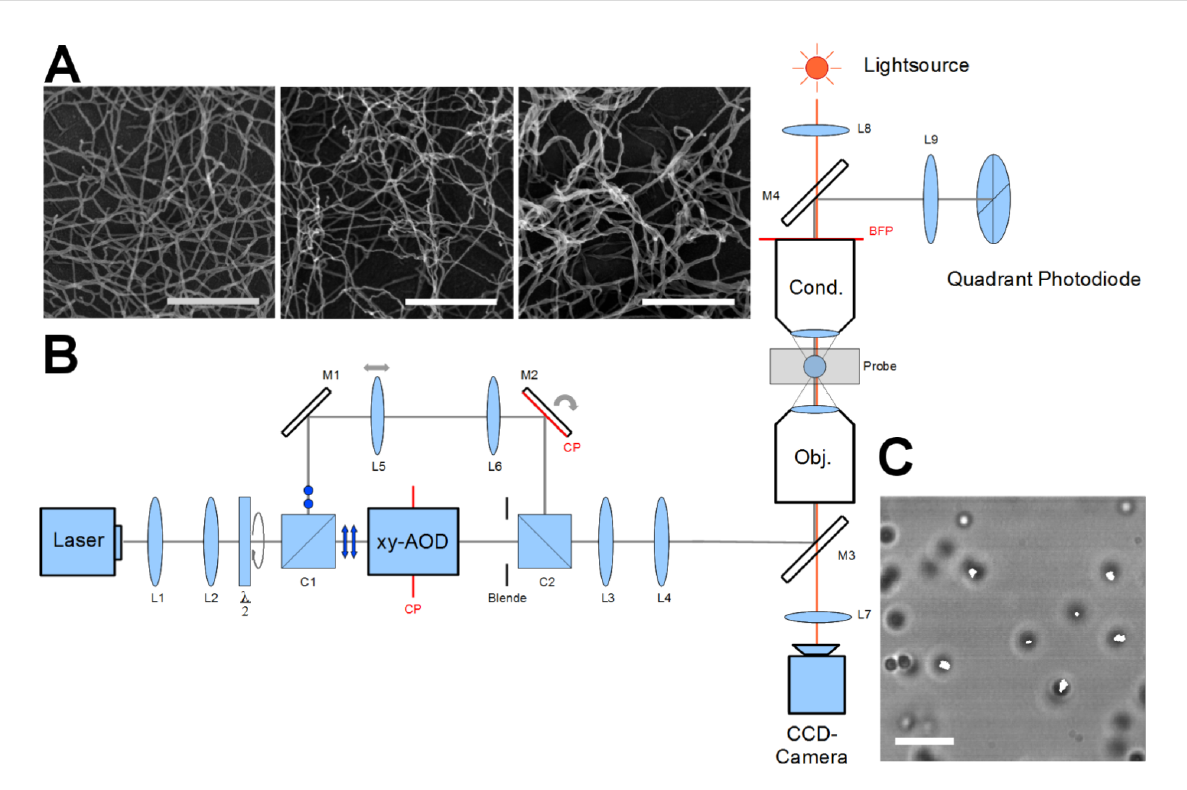
symmetry, the trapping beam pivots at the back focal plane of the objective. The setup of the optical tweezers and a screen- shot of the measurement of several particles in an in vitro assembled intermediate filament network are shown in Figure 4B,C. SEM images of the crosslinked networks can be seen in Figure 4A. From left to right the amount of crosslinker increases from 0 to 0.25 and to 1 mM MgCl. With increasing crosslinker concentration the network gets denser. Bundling of the filaments can be also seen for high crosslinker concentra-